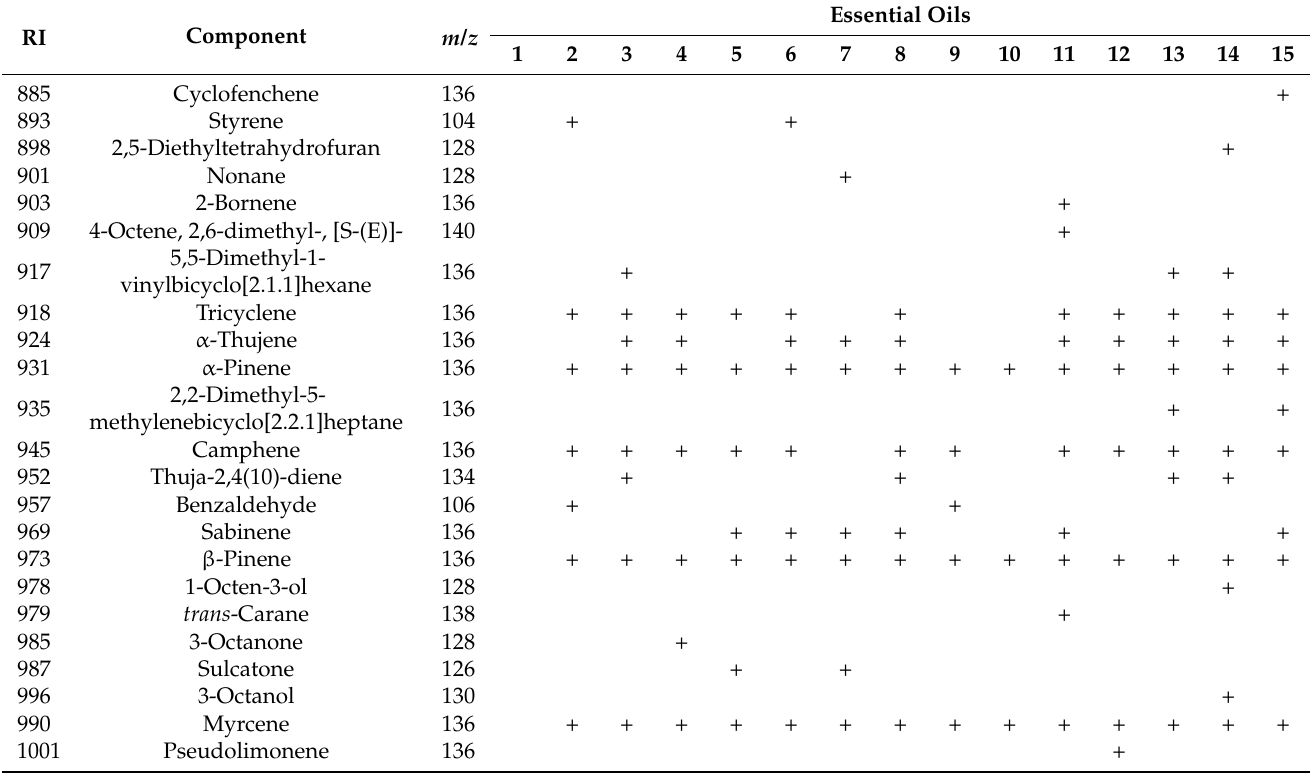
Table 2. Essential oils composition according to GC-MS data (RI—retention